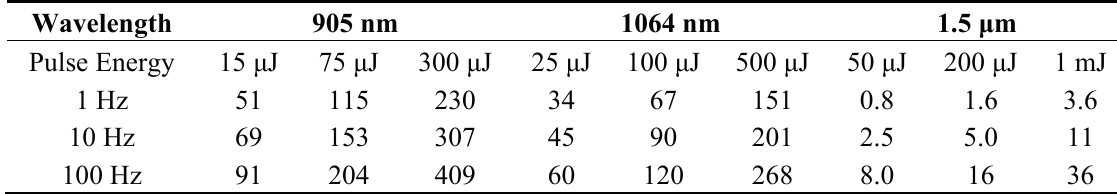
Table 5. Required beam diameters (in mm) at several repetition rates for the studied wavelengths and pulse energies.